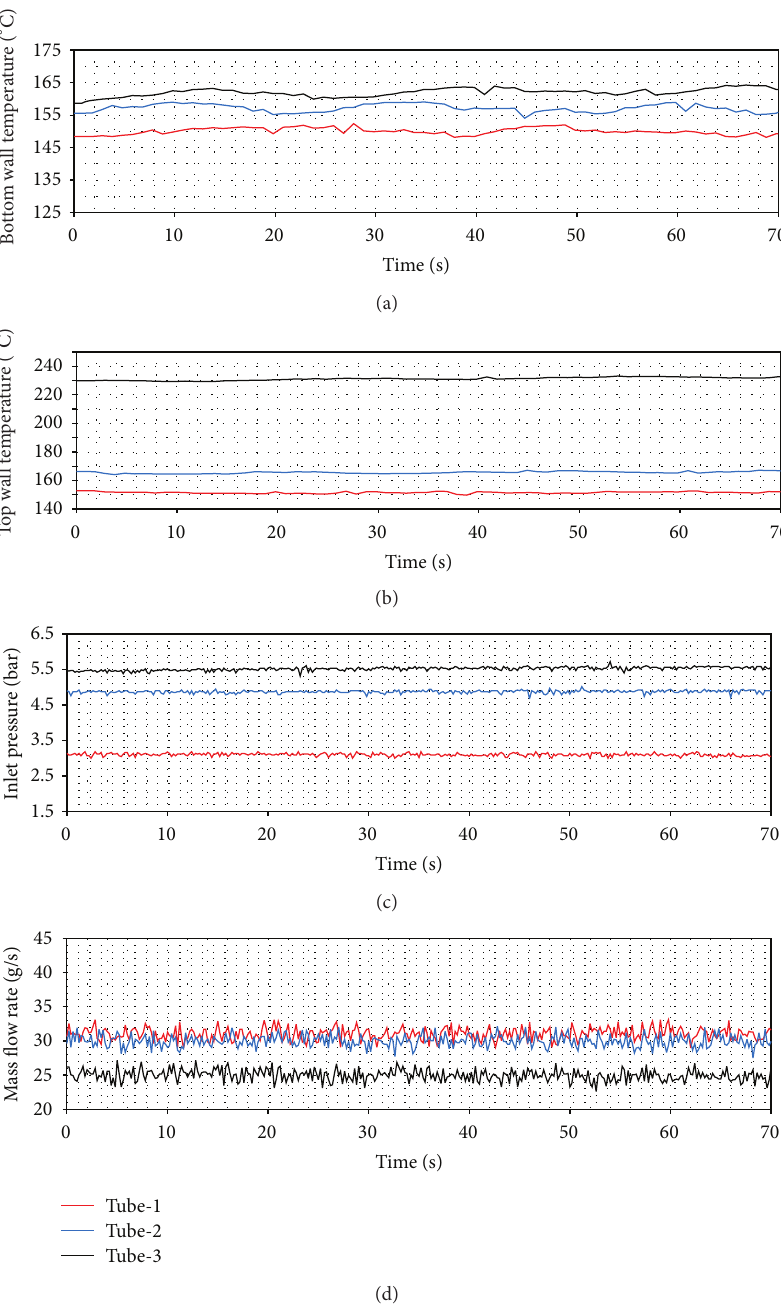
kW, C in ∘ 𝑇𝑇 𝑄 𝑄5 )